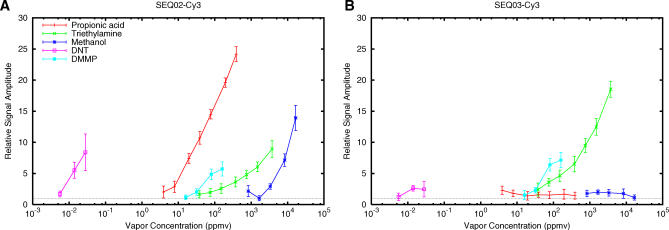
Odor Concentration-Response Curves Tested in the Artificial Nose for Two ssDNA Oligonucleotides Labeled with the Fluorescent Dye Cy3 during Synthesis(A) Responses from sequence SEQ02.(B) Responses from a different sequence SEQ03. Sensors were made from 20 μl of 10 μM oligomer. Each data point is the mean of 10 presentations; error bars indicate ± 1 SD.